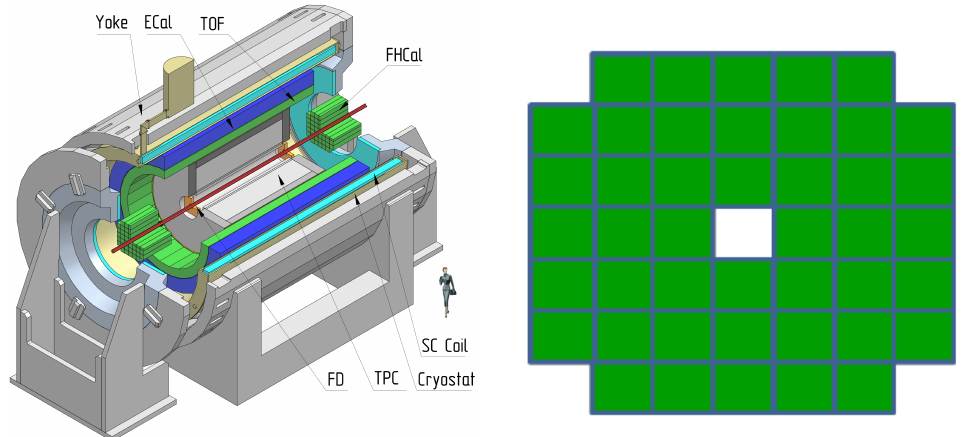
Figure 1. ( left ) The schematic view of the Multi-Purpose Detector (MPD) detector in Stage 1 ( right ). The module structure of the forward hadron calorimeter (FHCal) calorimeter (front